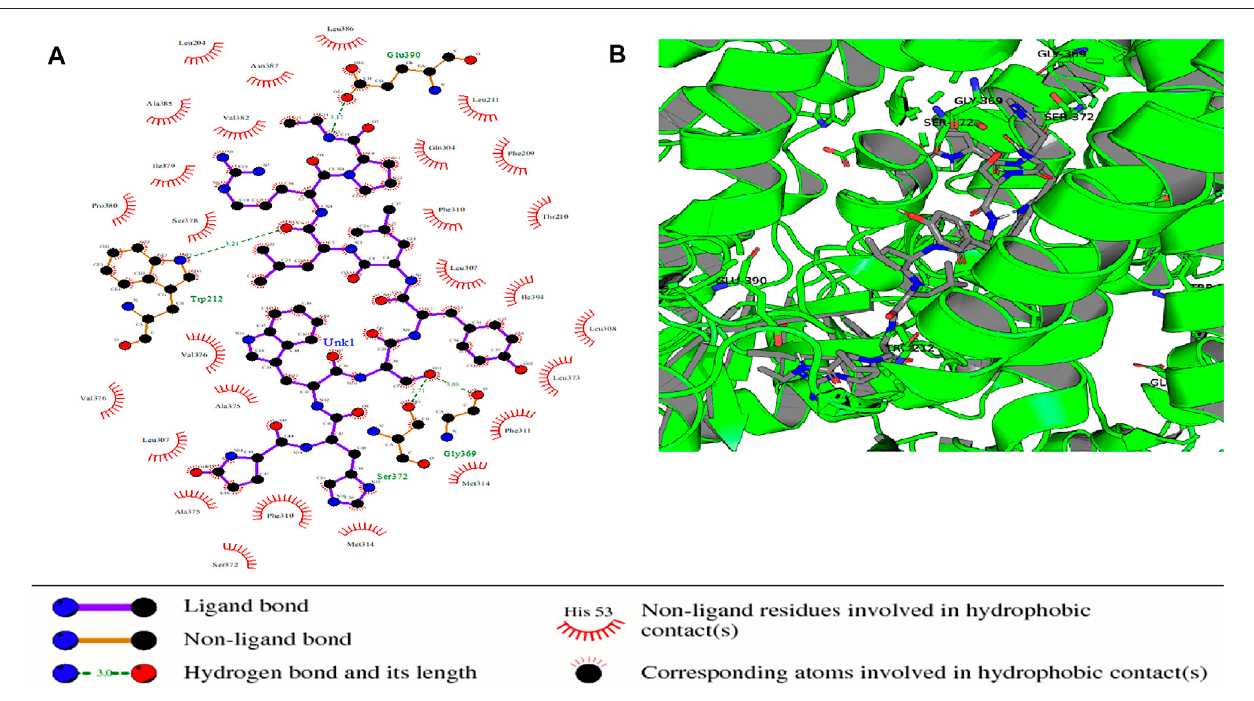
FIGURE9| Protein – ligandcomplexofSTEAP2andDrugbank2showsresiduesGlu-390,Gly-369,Ser-372,andGly-369withinthe6thand12thTMdomainform hydrogen bonds with ligand Drugbank